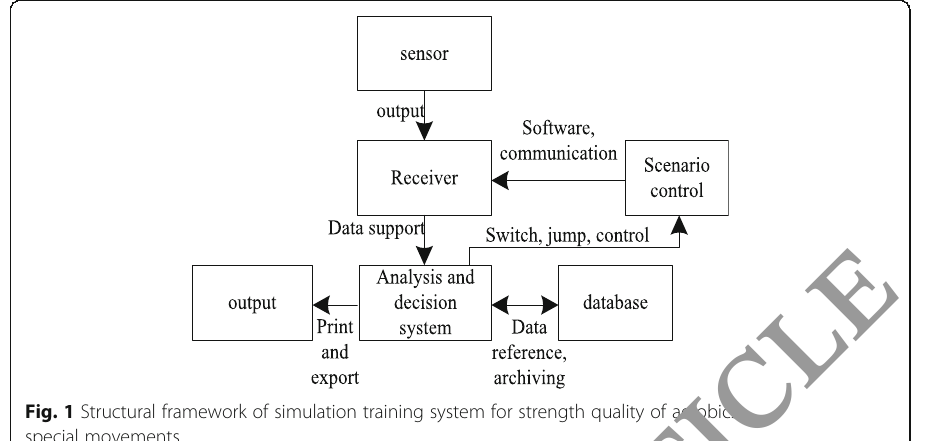
Fig. 1 Structural framework of simulation training system for strength quality of aerobics special